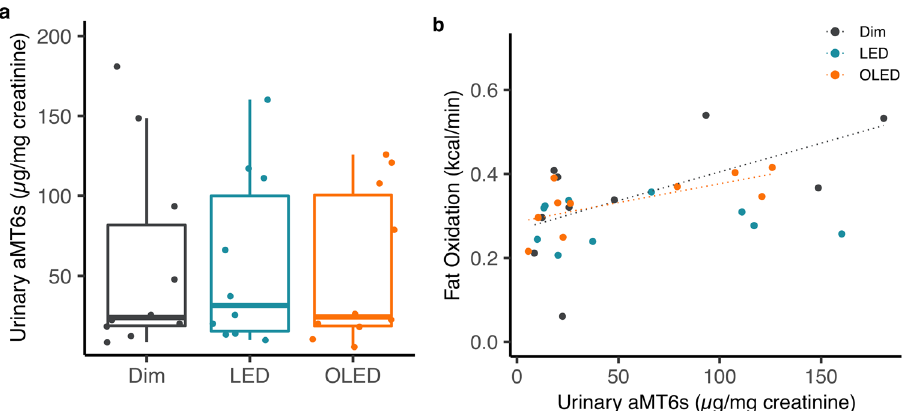
Figure 4. Urinary 6-sulfatoxymelatonin (aMT6s). ( a ) Concentration of total aMT6s normalized to urinary creatinine concentration. ( b ) Correlation between urinary aMT6s and fat oxidation of dim (black), LED (blue), and OLED (orange)